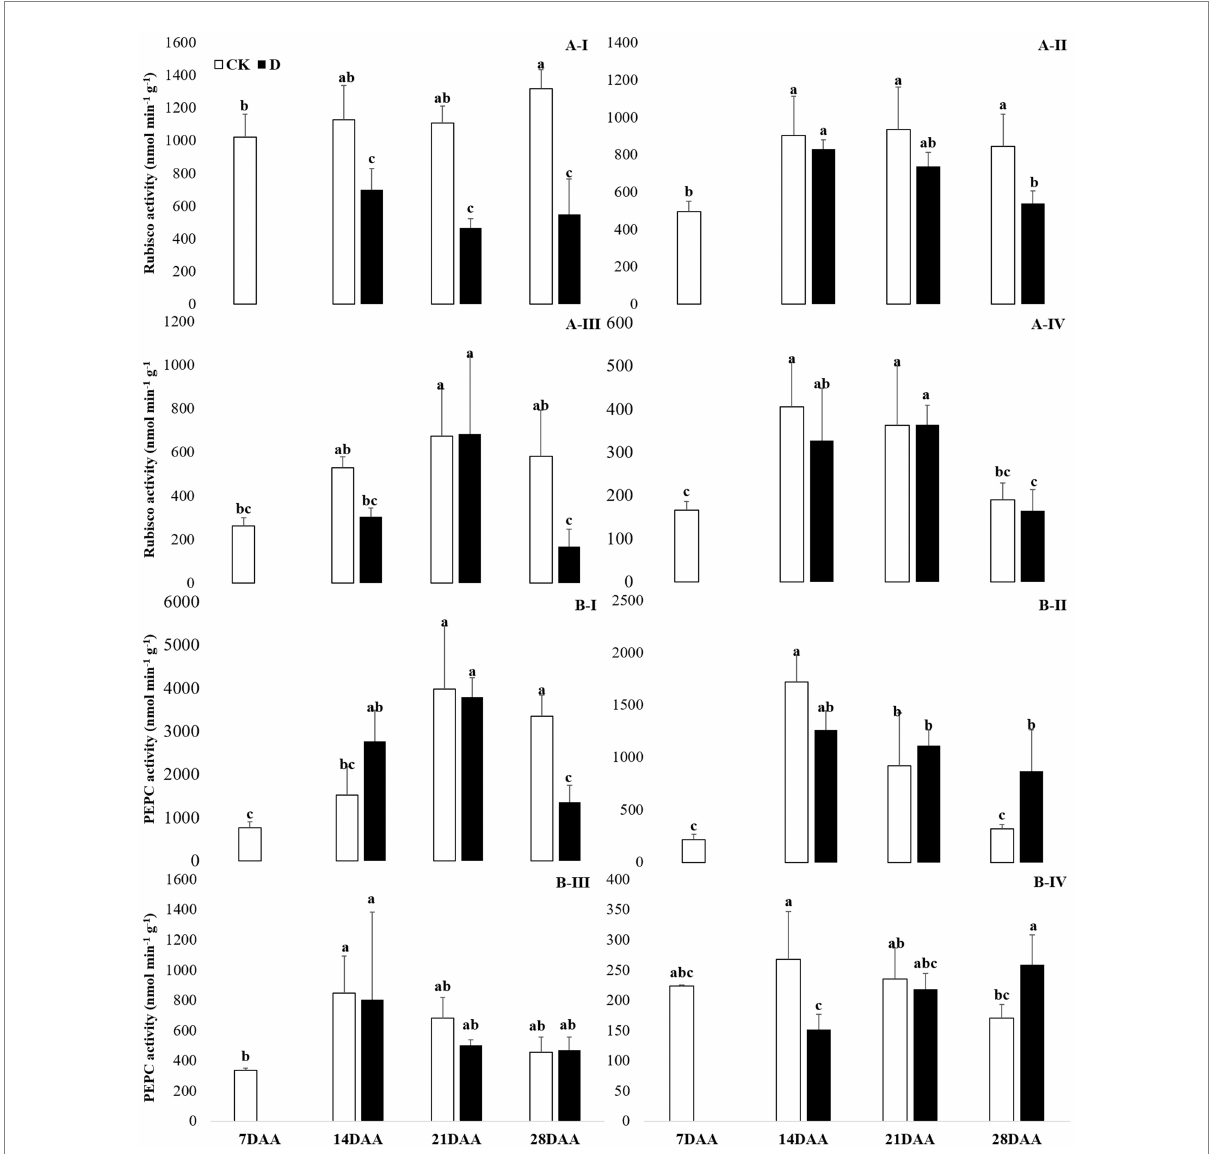
FIGURE 3 Rubisco (A) and PEPC (B) activity in the flag leaf (I) , the sheath (II) , the glume (III) and the lemma (IV) under drought stress. Different small letters within the same organ meant a significant difference at the 0.05 probability level.